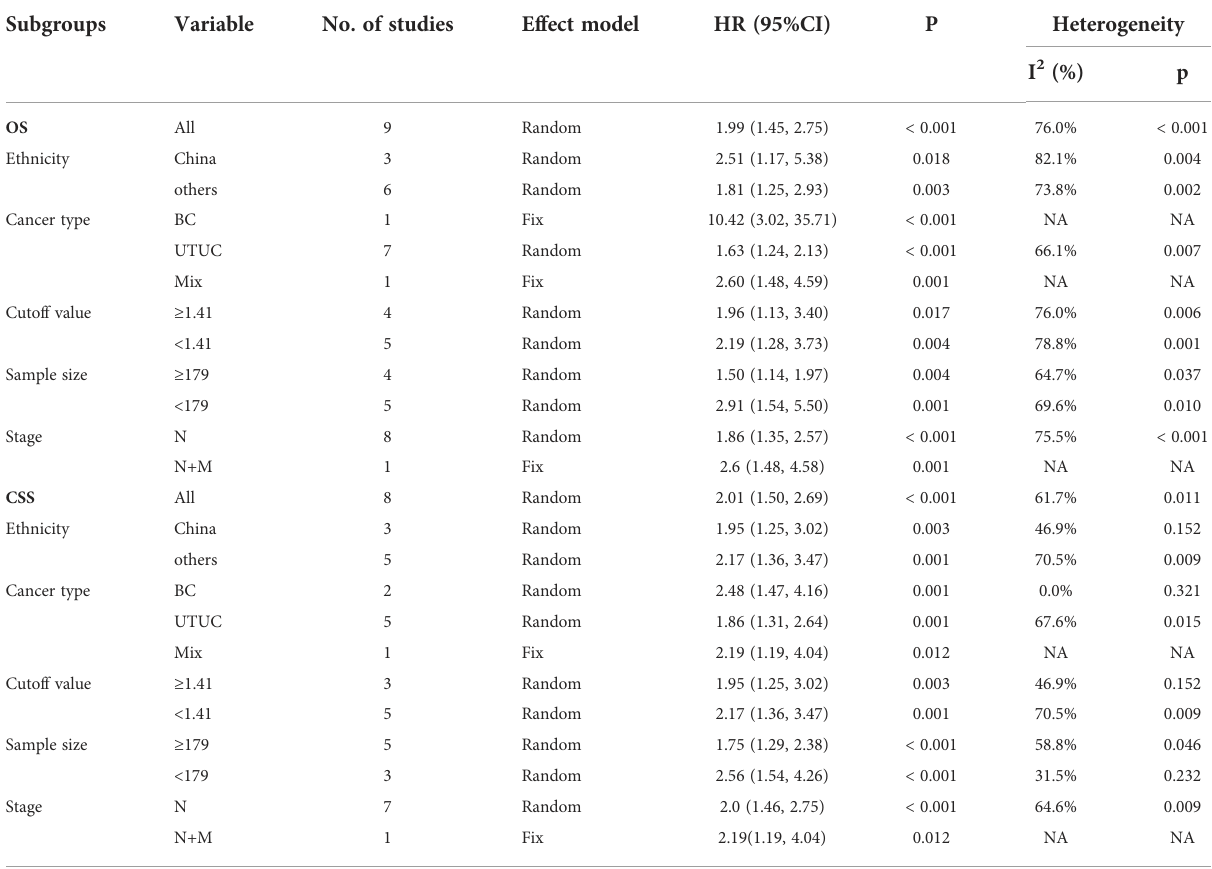
TABLE 2 Subgroup analysis of OS and CSS based on different in fl uencing